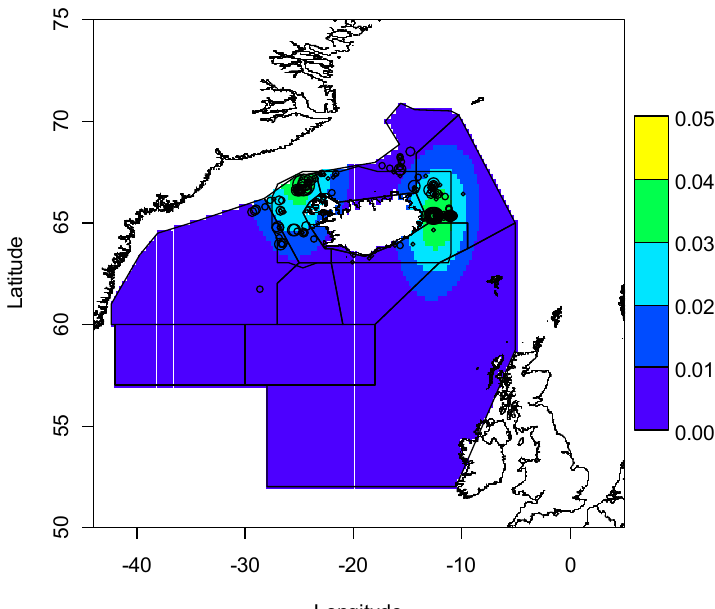
Fig. 6. Estimated whale density for NASS- 95 based on the combined aerial and ship surveys. Density estimates are on a scale 0 to 0.05 whales/km² (see